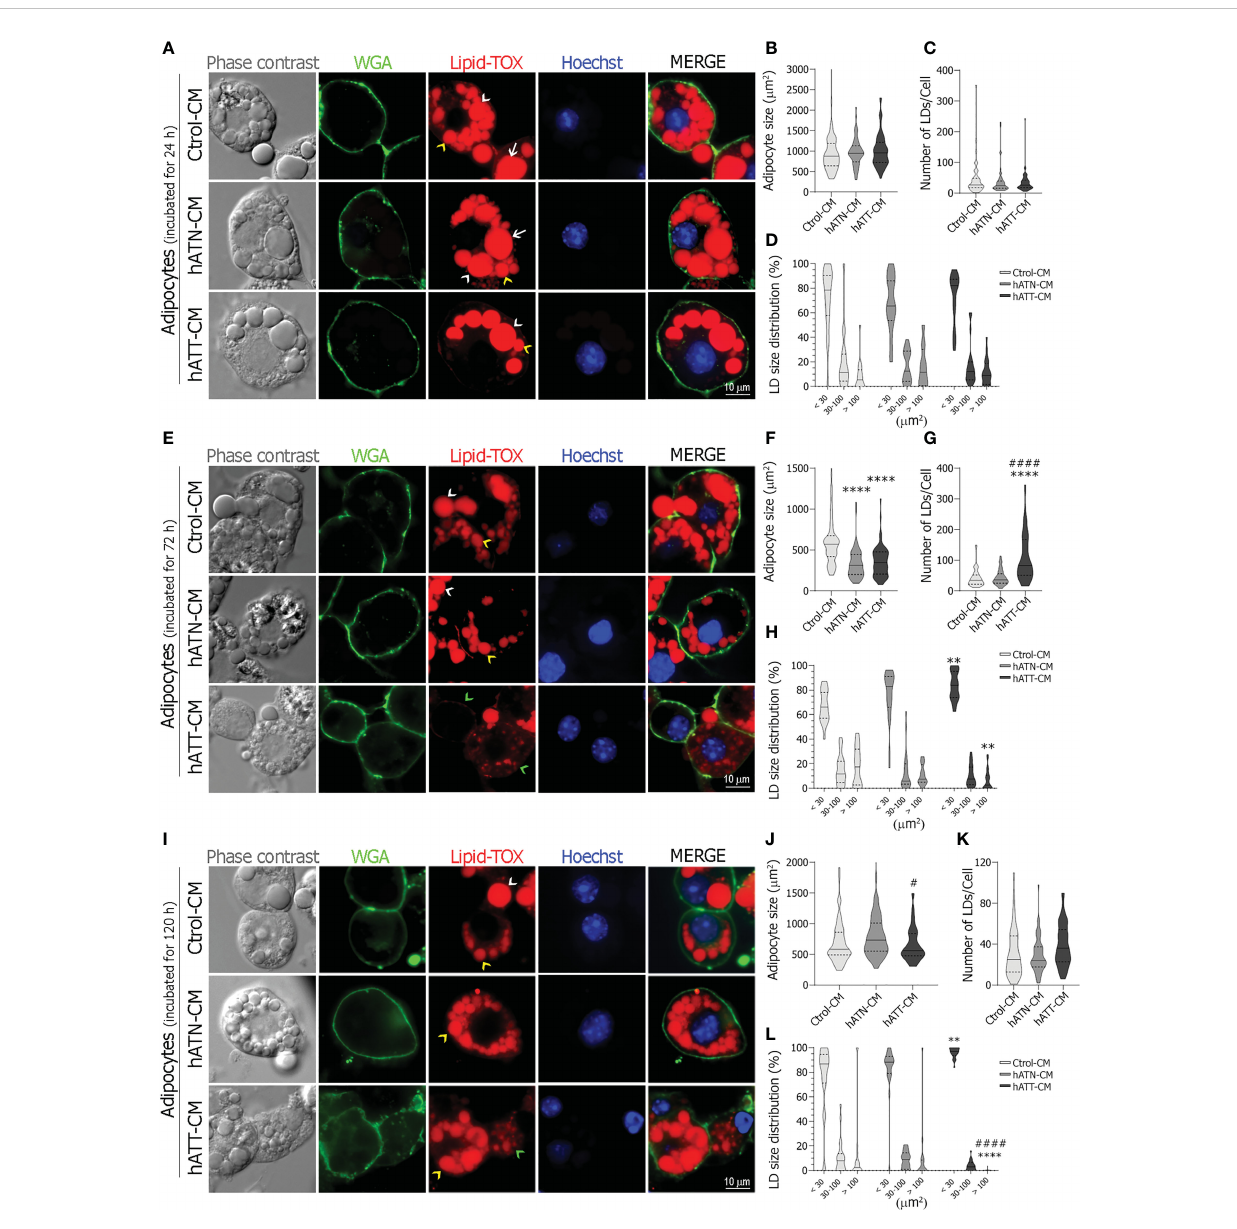
FIGURE 2 Effect of CM from hATN and hATT on morphological parameters in mature adipocytes. 3T3-L1 adipocytes were incubated with hATN-, hATT- or Ctrol-CM for 24 (A) , 72 (E) and 120 h (I) , subjected to IIF with the indicated antibodies, and images were analyzed by confocal microscopy (magni fi cation x600; see Materials and Methods section for further details). White arrows, white arrow heads, yellow arrow heads and green arrow heads show examples of large, medium, small and micro-LDs, respectively. Violin plots represent the adipocyte size ( m m 2 ) ( B, F, J , adipocytes incubated with the different CM for 24, 72 and 120 h, respectively), the number of LDs per cell ( C, G, K , adipocytes incubated with different CM for 24, 72 and 120 h, respectively) and percentage of LDs according to size (micro < 10 m m 2 and small 10 to 30 m m 2 , medium from 30 to 100 m m 2 , and large > 100 m m 2 ) ( D, H, L , adipocytes incubated with different CM for 24, 72 and 120 h, respectively) from 64 adipocytes (n = 3 experiments in duplicate). Tukey ’ s multiple comparison test was performed; **P<0.01, and ****P<0.0001 hATT-CM or hATN-CM vs. Ctrol-CM; #P<0.05, and ####P<0.0001 hATT-CM vs. hATN-CM. Ctrol-CM, control conditioned media; hATN-CM, conditioned media from human normal breast adipose tissue explants; hATT-CM, conditioned media from human breast cancer adipose tissue explants; LDs, Lipid droplets; WGA, Wheat germ